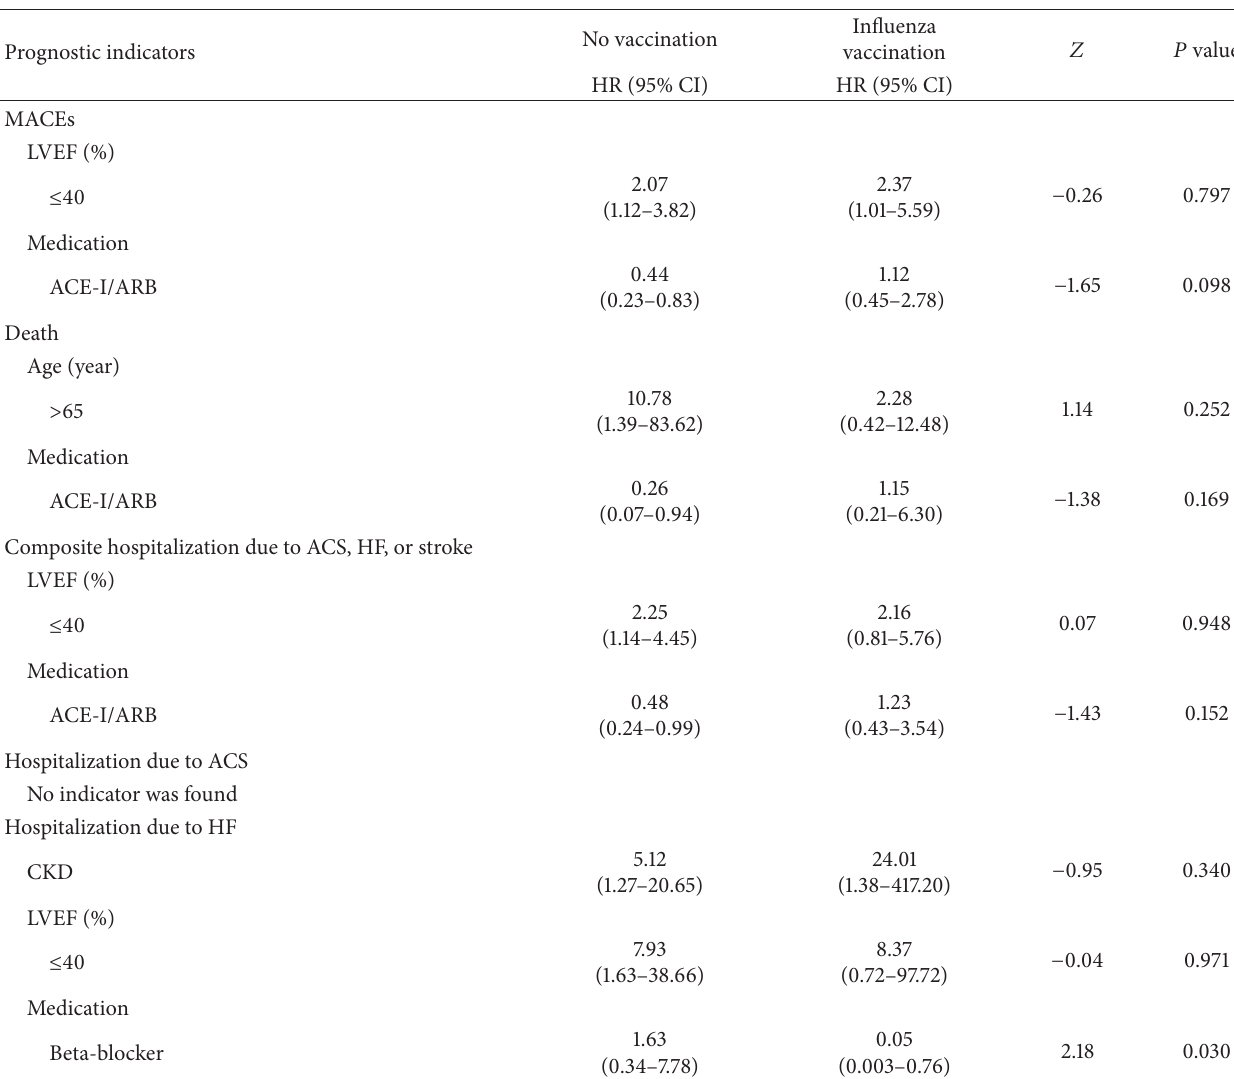
Table 4: Discrimination of multivariable hazard ratios by the influenza vaccination for each cardiovascular event.